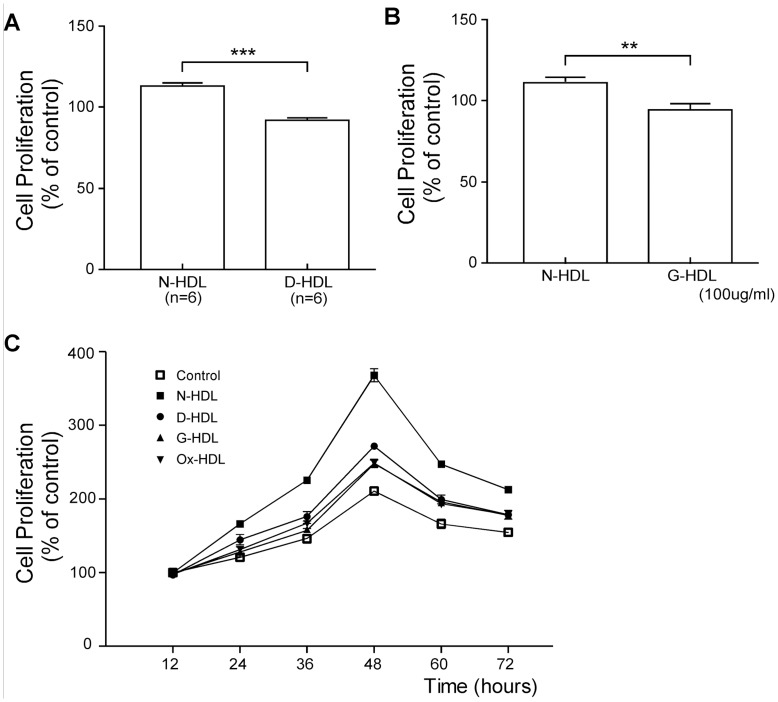
Diabetic HDL is less efficient in stimulating EC proliferation. A)HUVECs were treated with N-HDL and D-HDL for 24 hours, and cell proliferation was measured using MTT assay. Mean ± SEM, n = 6, ***, p<0.001 by student’s t-test. B) HUVECs were treated with N-HDL or G-HDL for 24 hours at apoA-I concentrations of 50 and 100 µg/ml respectively, and cell proliferation was measured using MTT assay. Although N-HDL promoted cell proliferation at 24 hours, G-HDL at 100 g/ml apoA-I decreased cell proliferation (mean ± SEM; **, p<0.01 by student’s t-test). C) HUVECs were treated with N-HDL, D-HDL, G-HDL or Ox-HDL for 12, 24, 36, 48, 60 or 72 hours at apoA-I concentrations of 100 µg/ml and cell proliferation using BrdU proliferation assay was shown (mean ± SEM; **, p<0.01 by ANOVA and Bonferroni’s Multiple Comparison Test).